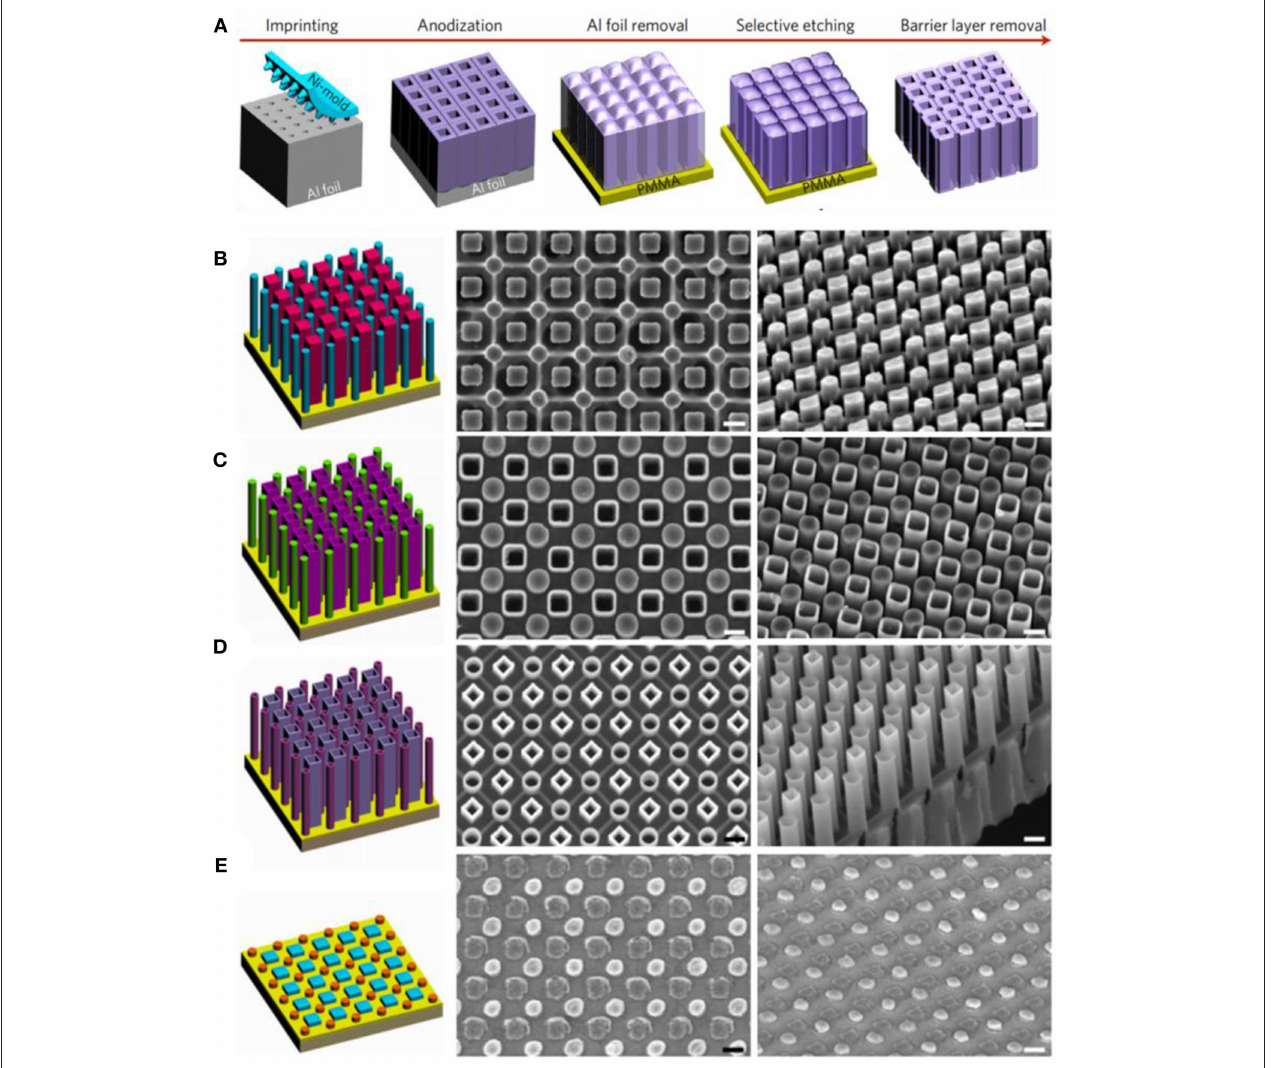
FIGURE 6 | (A) Schematic diagram of fabrication process for a highly ordered porous alumina matrix template. Illustration and corresponding SEM figures: (B) nanowire/nanowire; (C) nanowire/nanotube; (D) nanotube/nanotube; (E) nanodot/nanodot. Scales are 200nm. Reprinted with permission from Wen et al. (2017), copyright 2017 Macmillan Publishers Limited, part of Springer